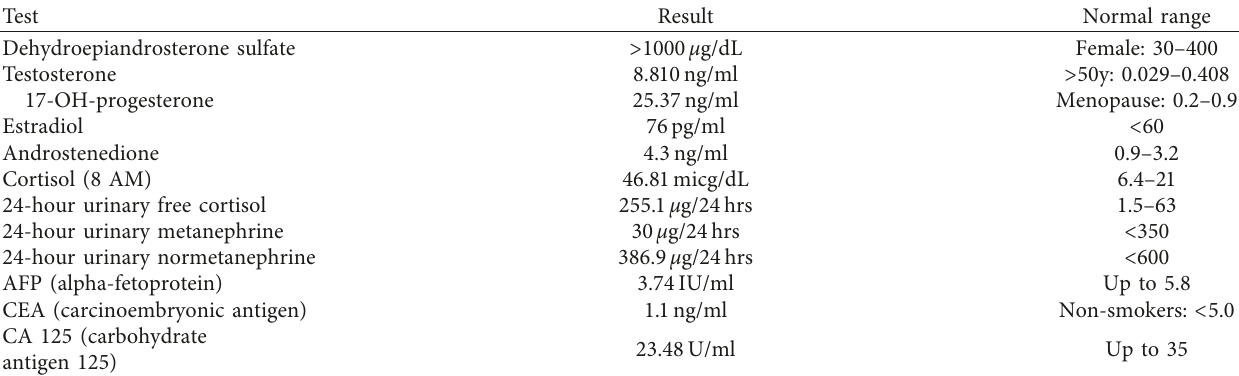
Figure 1: Abdominal CTscan with IV contrast. (a) Axial view of the heterogenous well-defined mass above the right kidney. (b) Coronal view of the adrenal mass effect on the IVC and pancreatic tail. Table 2: Hormonal and tumor marker evaluation